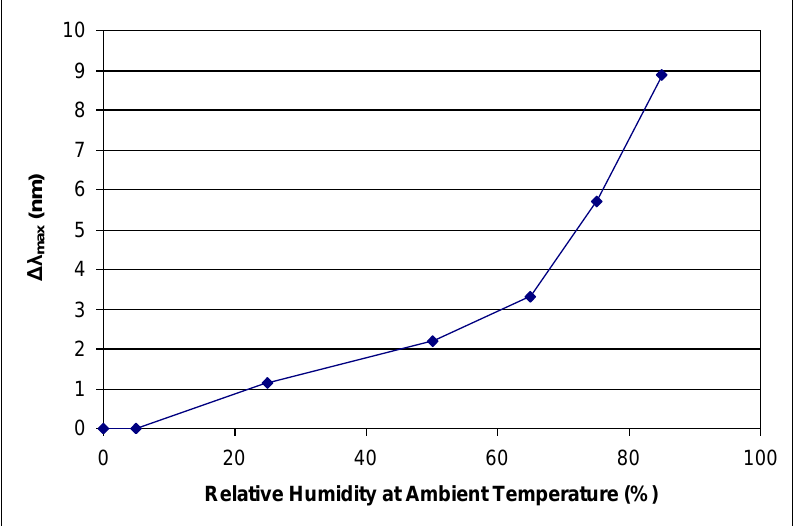
Figure 4. Response of current sensor to increasing relative humidities depicting a Type III isotherm.